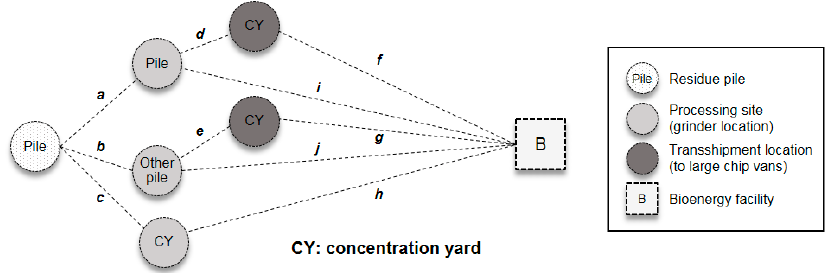
Figure 3. A network diagram representing a hypothetical configuration of in-woods grinding, slash forwarding, and large chip van transportation options.